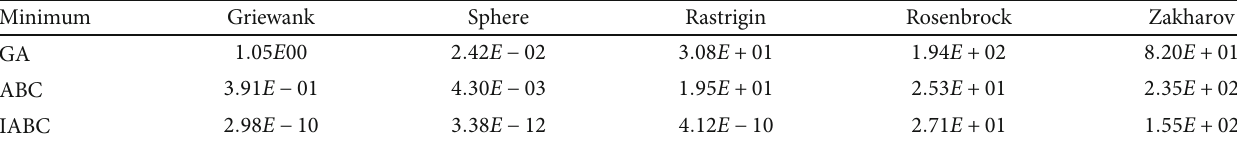
Table 1: Performance comparison of the IABC, GA, and ABC algorithms based on 5 benchmark functions [35].